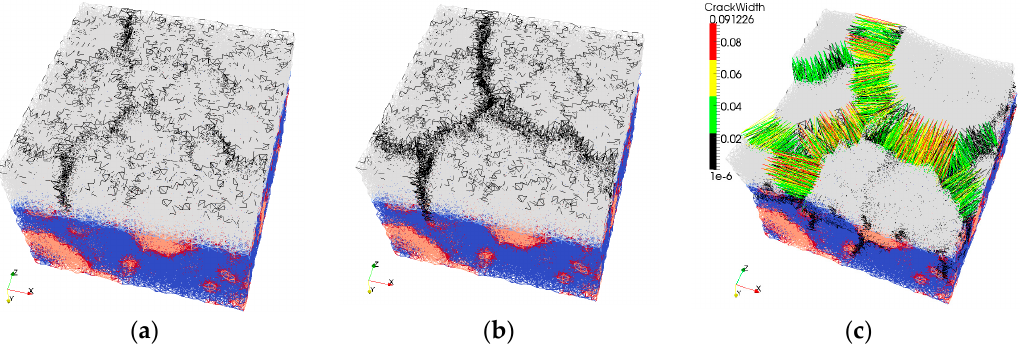
Figure 10. Crack development in the 10 mm thick repair material with smooth surface of substrate and high interface strength (3 MPa) at ( a ) 5000 damaged elements; ( b ) 10000 damaged elements and ( c ) final crack width at the age of 110 days.